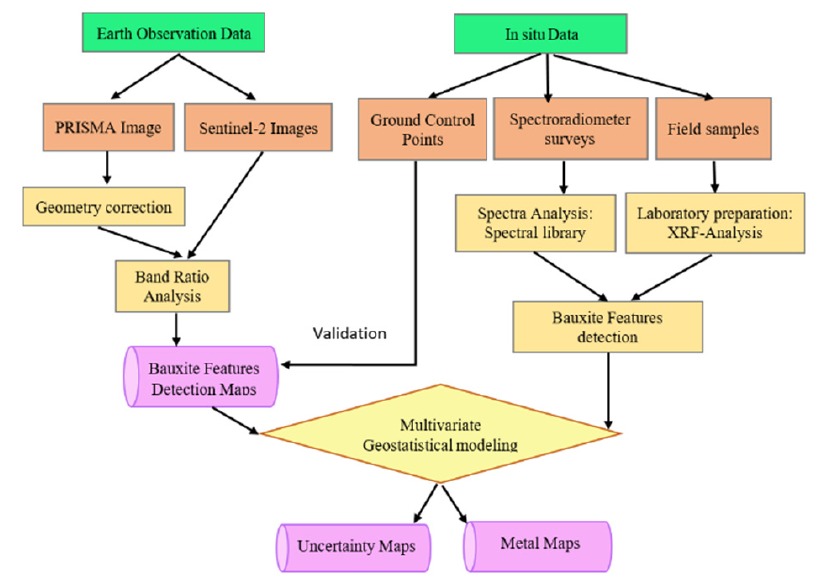
Figure 1. Methodology flowchart.